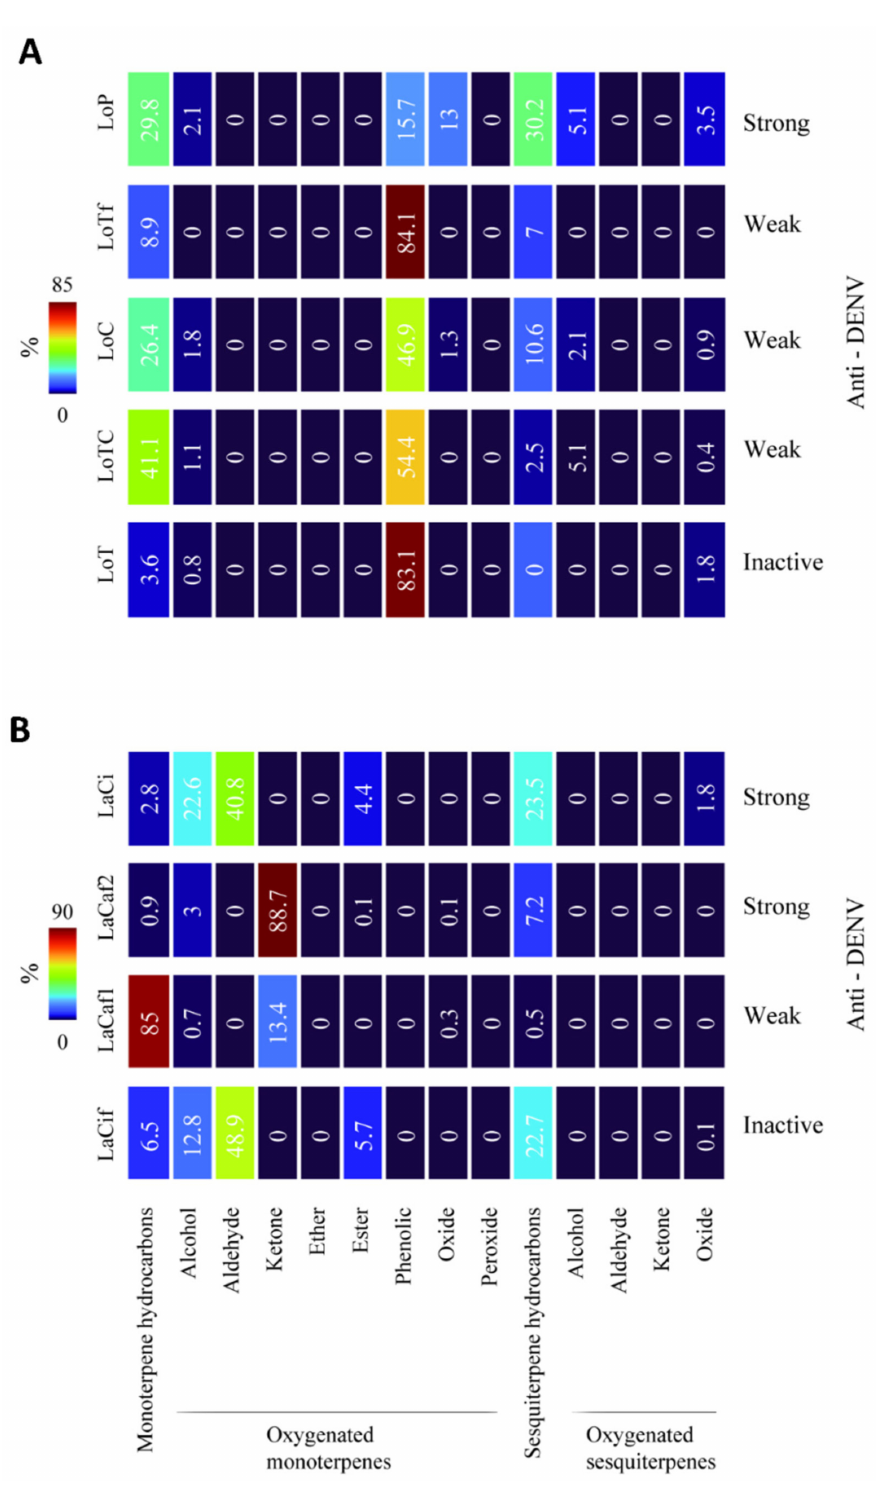
Figure 2. Antiviral activities of Lippia essential oils against dengue virus and terpene content. Heat maps representing the chemical composition in monoterpene and sesquiterpene types. Antiviral activity (Anti-DENV) was expressed as strong, weak, and inactive (Table 3). ( A ). EOs of L. origanoides chemotypes: neat EOs phellandrene EO (LoP); carvacrol (LoC); thymol-carvacrol (LoTC) and thymol (LoT); and thymol-rich fraction (LoTf). ( B ). EOs of L. alba : neat EO (LaCif) and light fraction (LaCif) of the citral chemotype; and limonene-rich fraction (LaCaf1) and carvone-rich fraction (LaCaf2) of the carvone